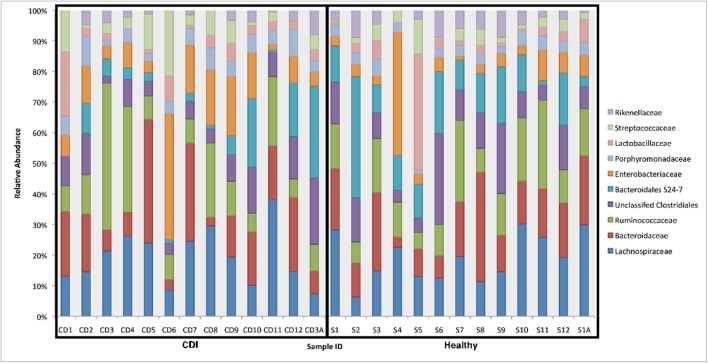
Relative abundance of bacterial families in CDI and non-CDI individuals. The relative abundance of the top 10 most abundant bacterial families for CDI (n = 13) and control (n = 13) fecal samples. Relative abundance of taxa was determined based on the relative abundance of 16S rRNA gene sequences assigned to a given bacterial family using the Greengenes database.